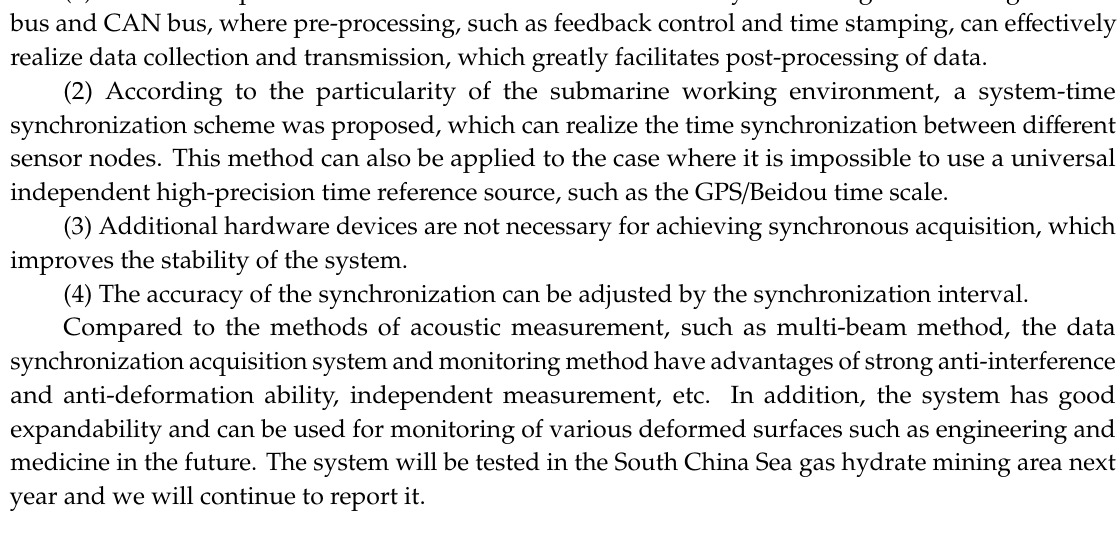
Figure 19. Point cloud data obtained by 3D laser scanner.